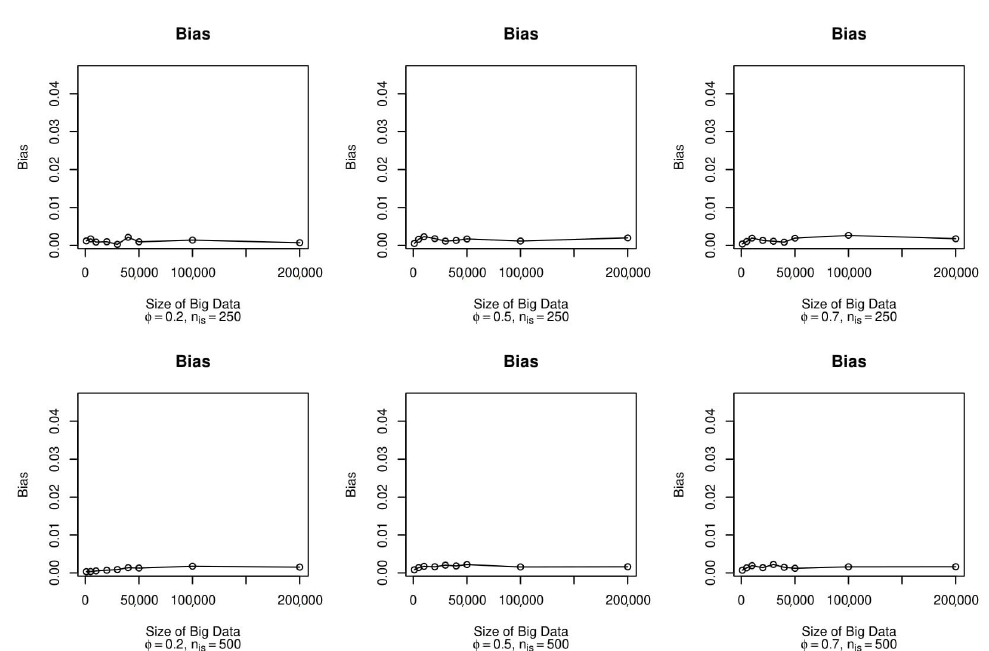
Figure 8. Bias for the real case, according to the size of the big data, φ , and n is .